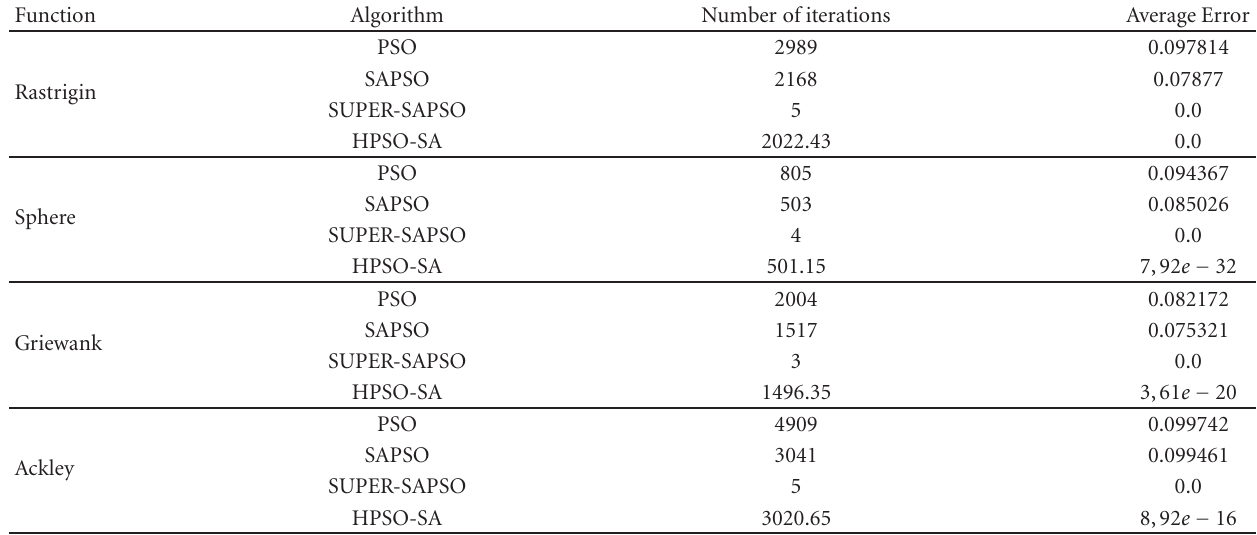
Table 4: Performance results of HPSO-SA, SUPER-SAPSO, SAPSO, and PSO algorithms on benchmark functions. Function